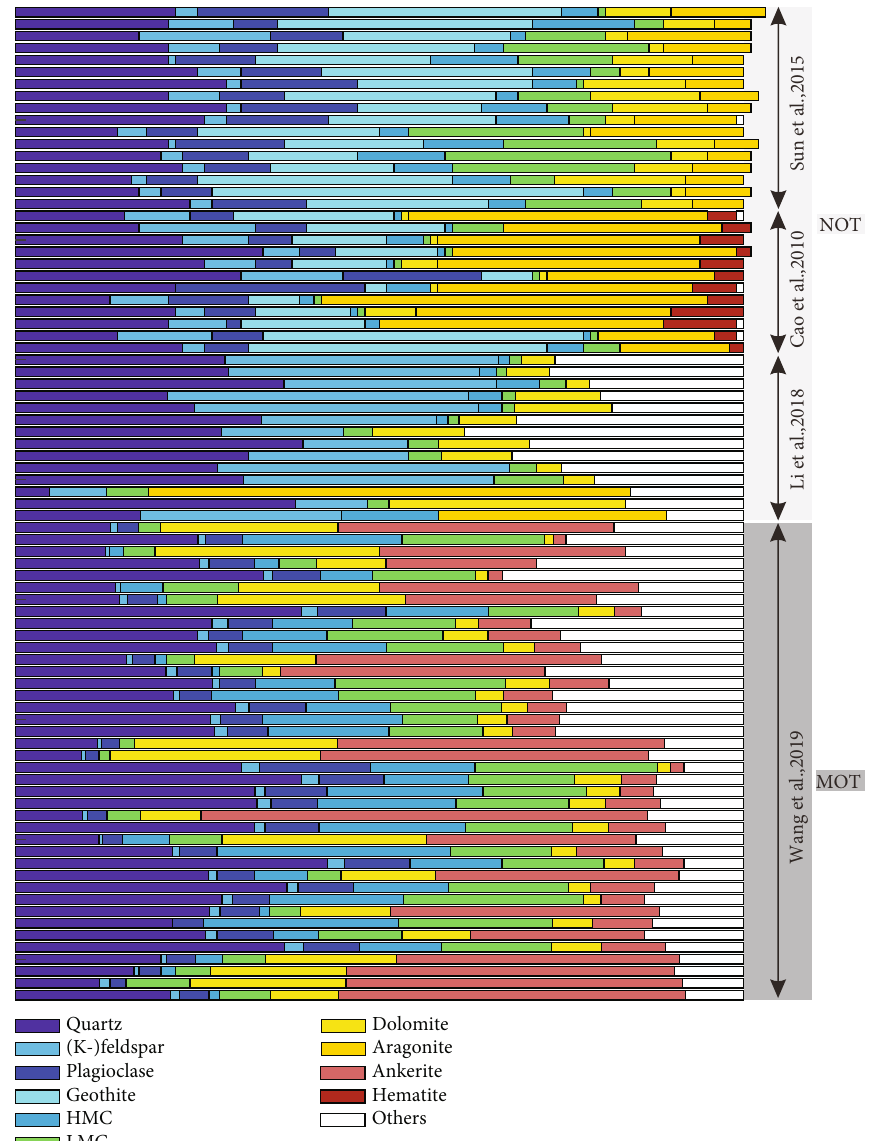
Figure 7: The mineralogical compositions of the MDACs in the northern and the middle Okinawa Trough (NOT and MOT,